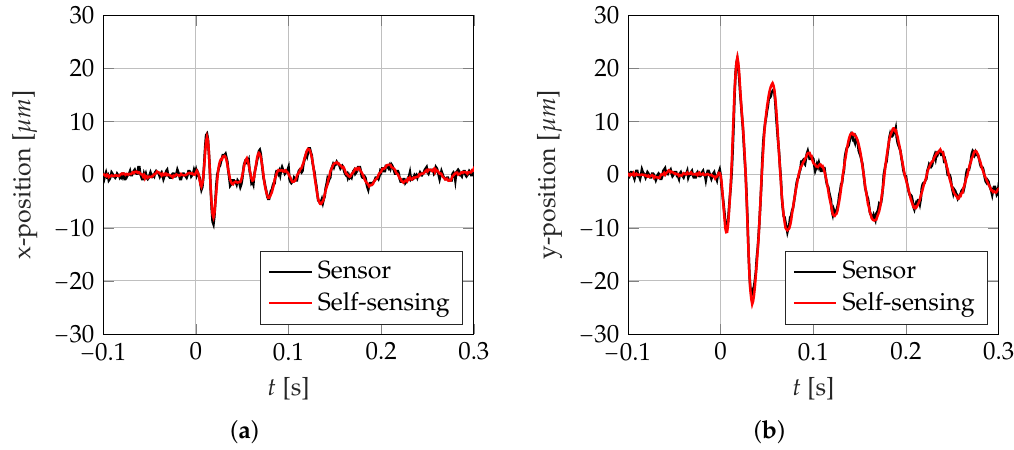
Figure 20. Comparison of the small signal behavior between an external sensor and the self-sensing method. A disturbance is applied at t = 0 s ( a ) x-position ( b ) y-position ( f PWM = 20 kHz, 6-Active